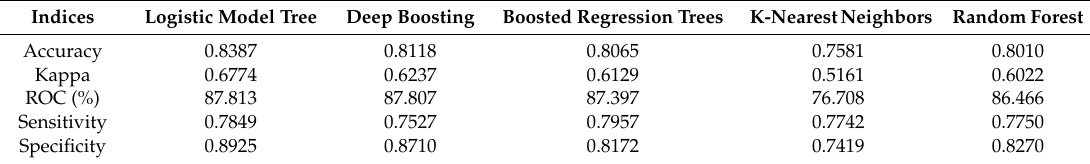
Table 3. Evaluation of the advanced machine learning algorithms (MLAs) with di ff erent indices.